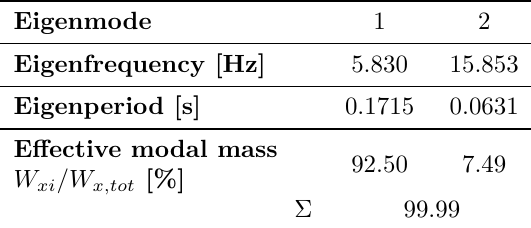
Table 1. Eigenvalue properties of the pliable stiff cross-beam.